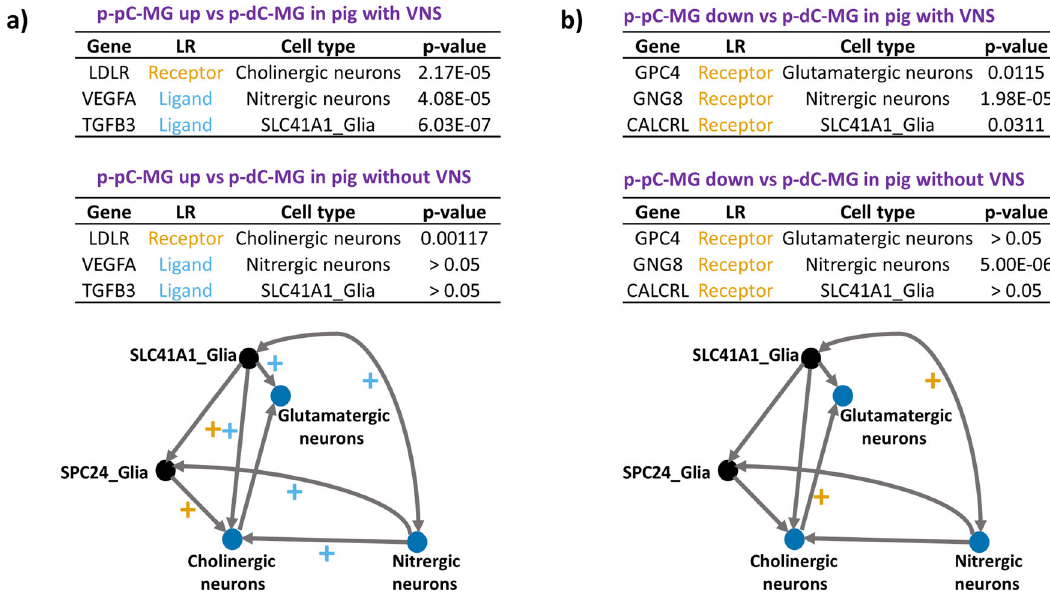
Fig. 10 The response of cell-cell interactions to vagal nerve stimulation in neuronal and glial subsets. The alterations were estimated through differential expression (p-value) of ligands (sky blue) and receptors (orange) expressed in neuronal and glial subsets in myenteric ganglia (MG) with vagal nerve stimulation (VNS) compared with those without VNS. + labels the upregulated interaction of cell subsets where there are the genes expressing ligands/ receptors with smaller p-value under VNS. The upregulated a and downregulated b genes encoding both ligands and receptors in myenteric ganglia (MG) with or without VNS were compared between the porcine proximal and distal colon (p-pC,